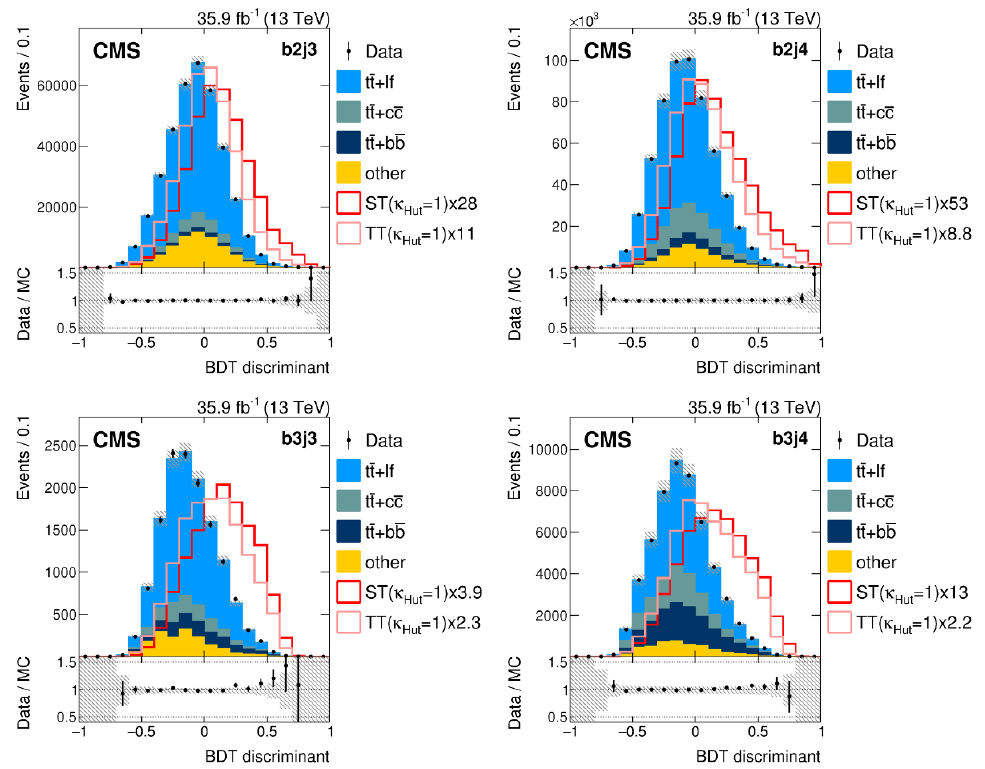
Figure 3 . The BDT discriminant distributions for di(cid:11)erent jet categories for Hut training after the (cid:12)t to data. All background processes are constrained to the SM expectation in the (cid:12)t. The shaded area corresponds to the total uncertainty in the predicted background. The data-to-simulation ratio is also shown. The distributions for the signal processes are normalized to the total number of events in the predicted background to ease the comparison of the shapes of the distributions.